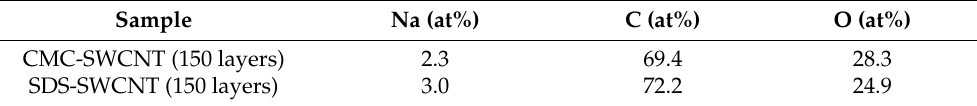
Table 1. Quantitative elemental composition (at%) of the CMC-SWCNT (150 layers) and CMC-SDS (150 layers) films, obtained from XPS